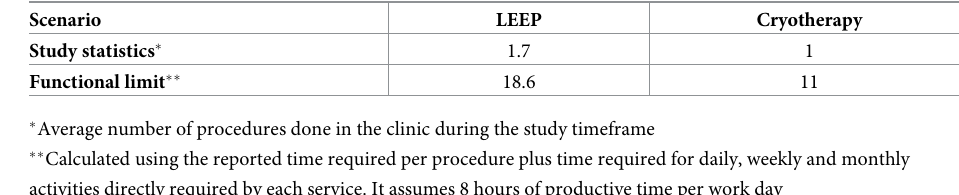
Table 3. Caseload scenarios: Total procedures per day per study nurse or doctor.